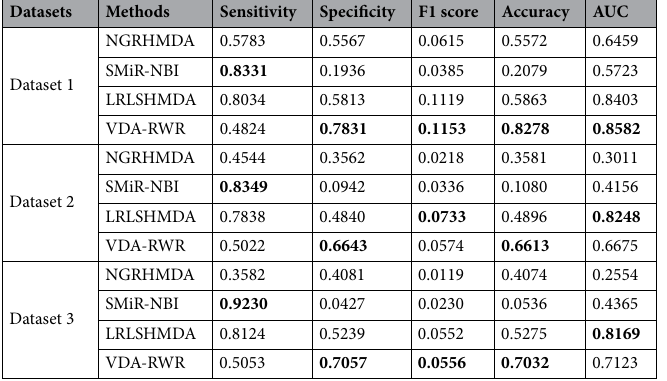
Table 4. The performance comparison of four methods on three datasets under CV3. Bold values indicates the best values for the different methods under the same